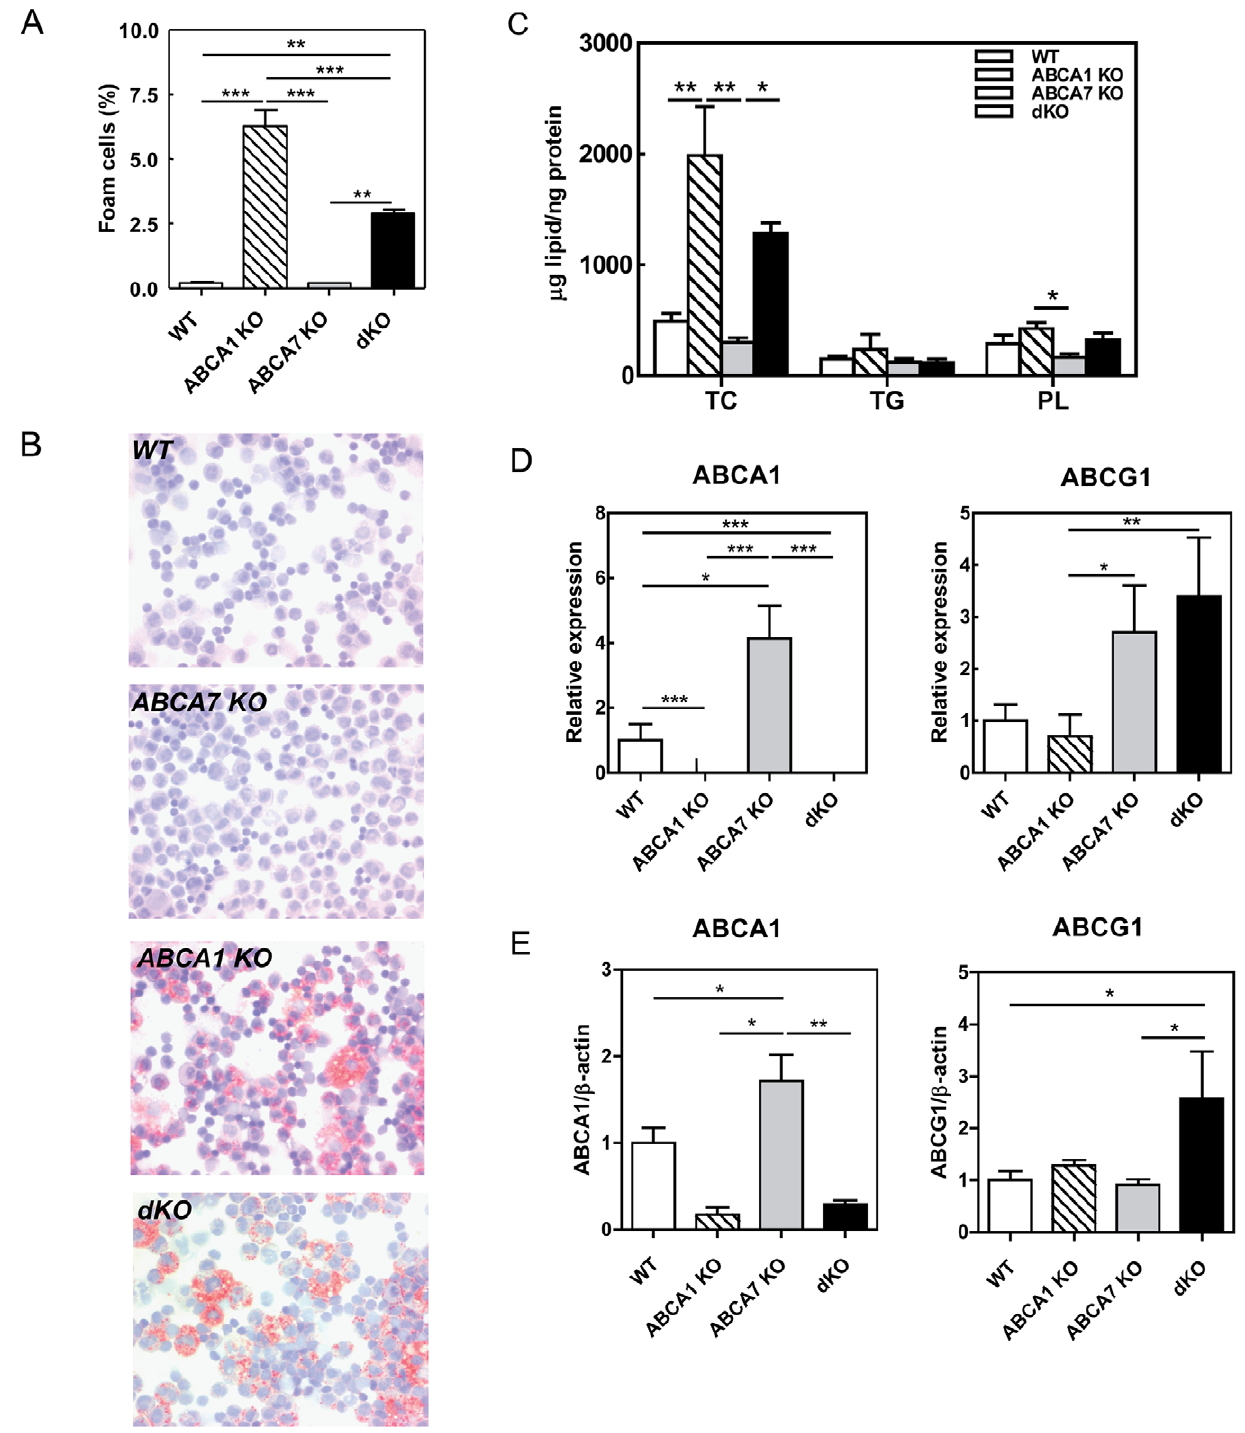
Figure 3. Effect of macrophage ABCA1, ABCA7, and combined ABCA1/ABCA7 deficiency on invivo foam cell formation, and mRNA and protein expression levels of ABCA1 and ABCG1. ( A ) Peritoneal leukocytes were analyzed using a hematology Sysmex XT-2000iV analyzer and the number of macrophage foam cells were quantified as percentage of the total amount of isolated cells. Values represent the mean 6 SEM of $ 5 mice per group. Statistically significant difference **p , 0.01, and ***p , 0.001 vs. WT. ( B ) Photomicrographs of oil-red O-stained cytospins of peritoneal cells. Original magnification 6 400. ( C ) Lipids were extracted from peritoneal leukocytes with organic solvents. ( D ) Guanidium thiocyanate- phenol was used to extract total RNA from peritoneal macrophages and mRNA expression was determined by real-time RT-PCR. Hypoxanthine Guanine Phosphoribosyl Transferase (HPRT), b -actin, and acidic ribosomal phosphoprotein PO (36B4) were used as the standard housekeeping genes. Relative gene expression was calculated by subtracting the threshold cycle number (Ct) of the target gene from the average Ct of housekeeping genes and raising two to the power of this difference. WT samples were all calibrated to an arbitrary unit. ( E ) Western-blot analyses were performed to quantify the protein expression levels of ABCA1 and ABCG1 in peritoneal leukocytes. Values represent the mean 6 SEM of 4–6 mice per group. Statistically significant difference *p , 0.05, **p , 0.01 and ***p , 0.001. doi:10.1371/journal.pone.0030984.g003 PLoS ONE |